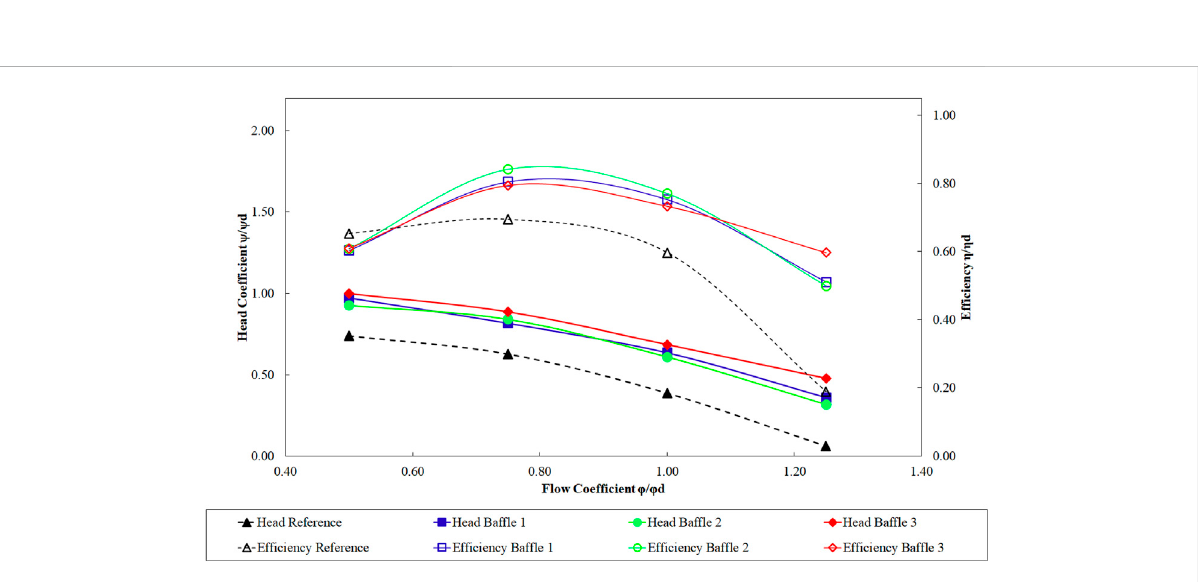
FIGURE 7 Performance comparison of stage